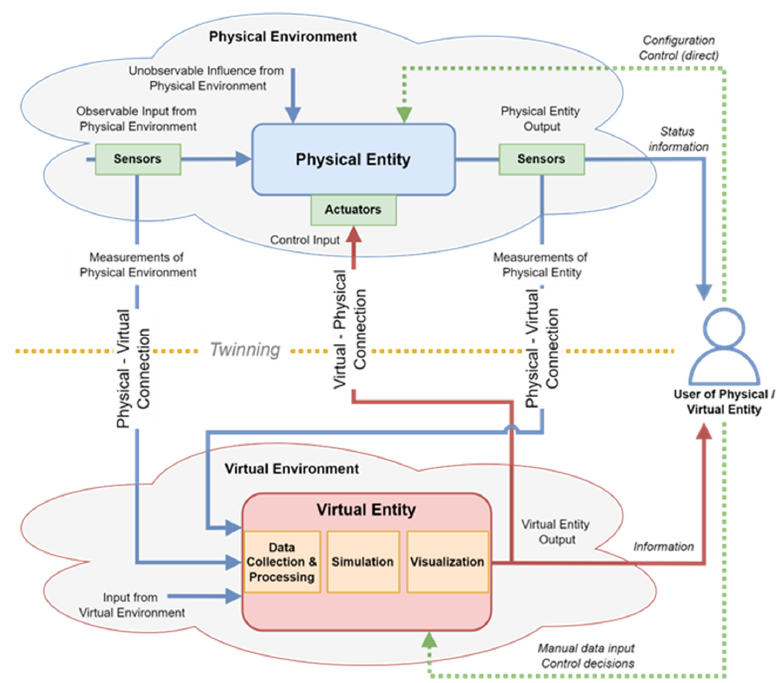
Figure 6. Generic conceptual structure of a digital twin.